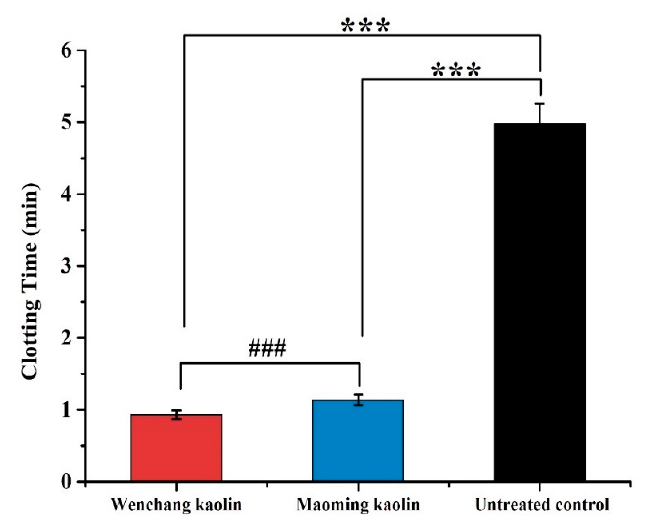
Figure 8. Plasma recalcification time (PRT)_of the two kaolin samples and the untreated control (n = 6). (*** indicates extraordinary difference with untreated control and p < 0.001, ### indicates extraordinary difference between the PRT of two kaolins and p < 0.001).